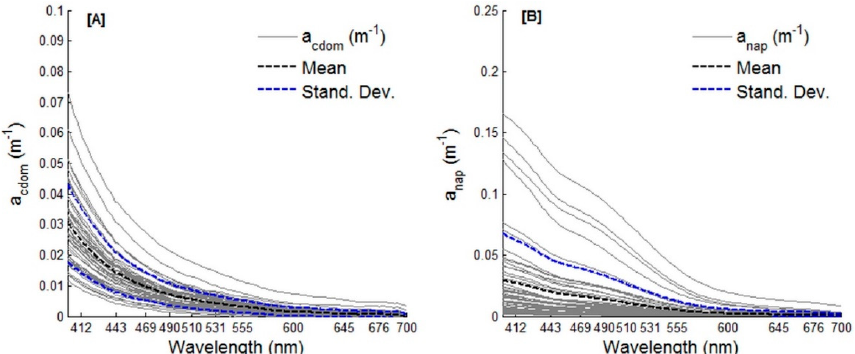
Figure 5. Coloured dissolved organic matter (CDOM) absorption ( a cdom ) spectra ( A ) and non-algal particles (NAP) absorption ( a nap ) spectra for each station, mean and standard deviation for all stations ( B ) (Number of samples = 52).